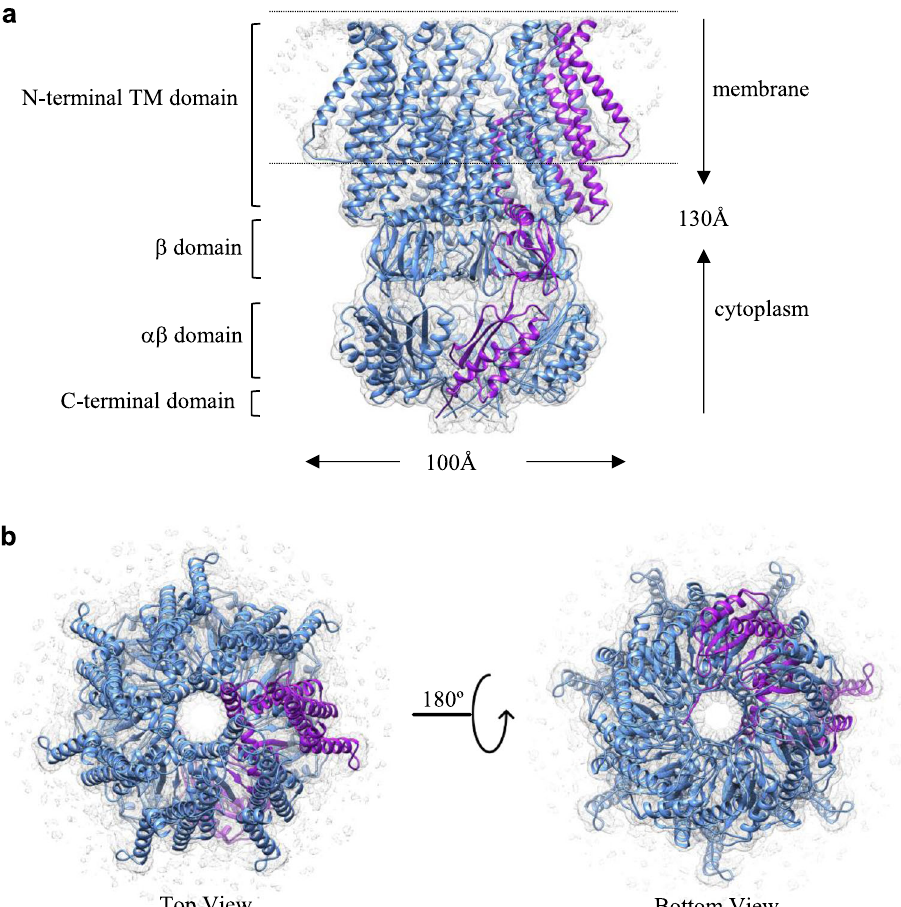
Fig. 1 Overall architecture of YnaI. a Side view of the atomic model of heptameric YnaI (blue with one subunit in purple) fi ts into its cryo-EM density map (gray). b Top (left) and bottom (right) views of